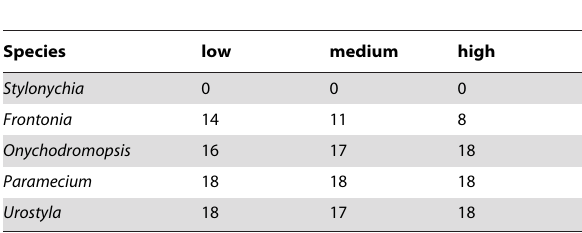
Table 2. Final patch occupancy of the five species in the three connectivity